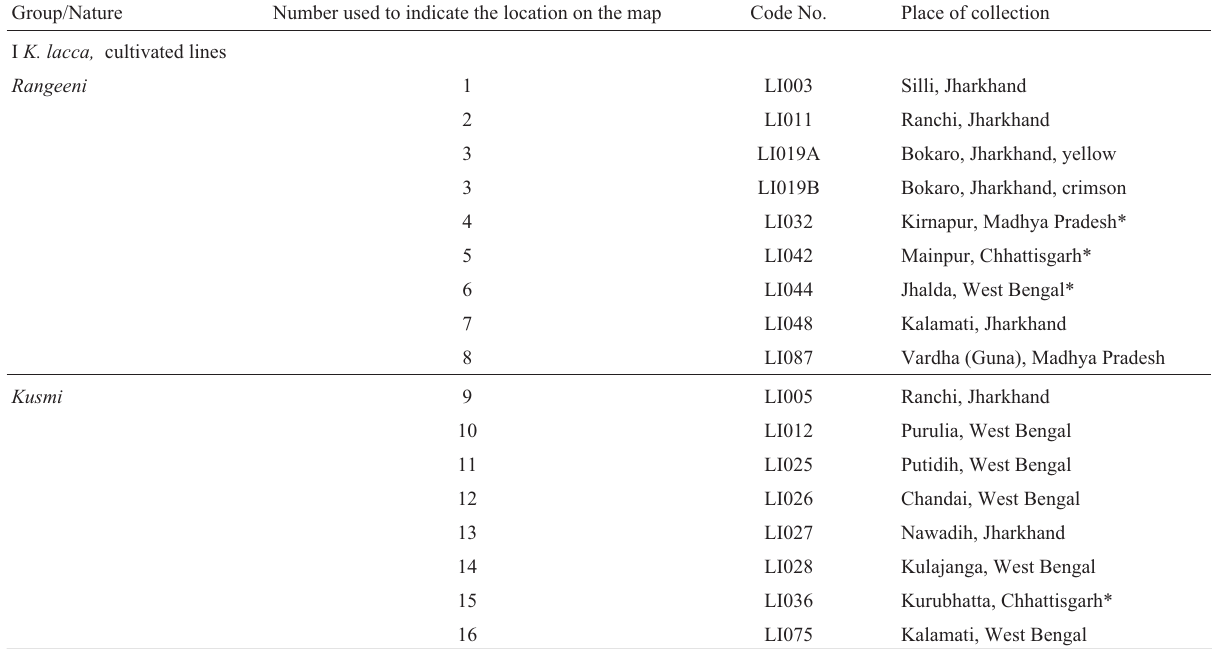
Table 1 - Details of the 48 lines of Kerria studied, including coding and place of collection. Group/Nature Number used to indicate the location on the map Code